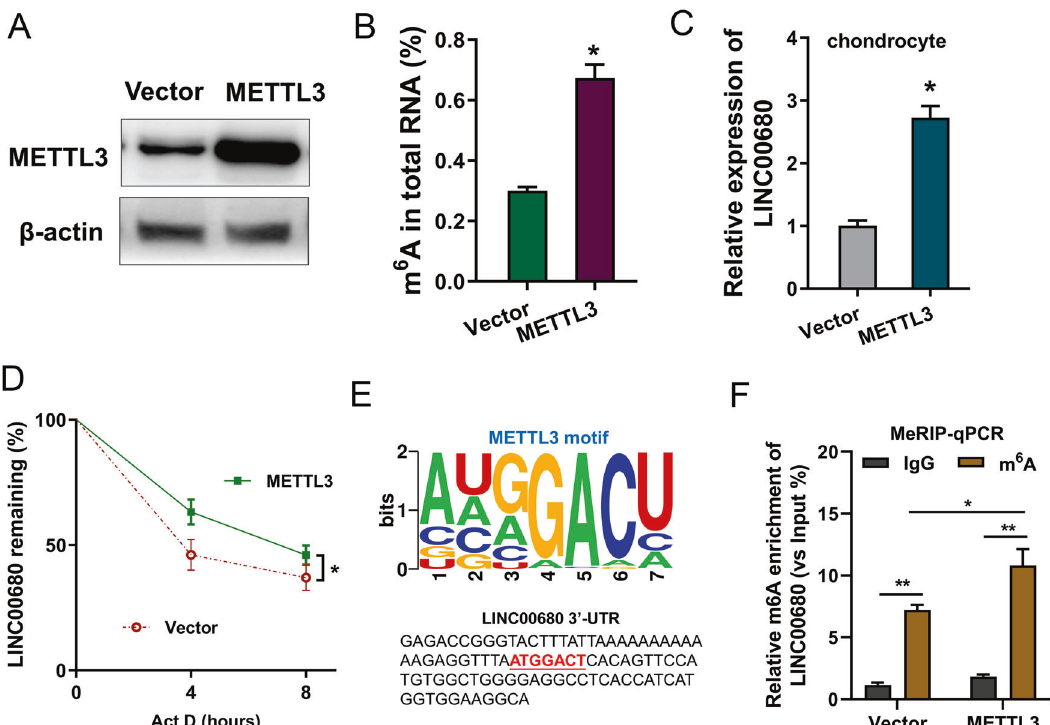
Fig. 2 METTL3 enhanced the stability of LINC00680 in IL-1 β -induced chondrocyte. A Western blot analysis detected the METTL3 protein level in IL-1 β -induced chondrocyte transfected with METTL3 overexpression plasmids. B m 6 A modi fi cation quantitative analysis indicated the m 6 A modi fi cation enrichment upon the METTL3 overexpression as compared to control. C RT-qPCR analysis was performed to quantify the LINC00680 expression in chondrocyte upon the METTL3 overexpression as compared to control. D Act D treatment (2 mg/mL) for RNA stability was performed to detect LINC0068 expression using RT-qPCR. E Online predictive tools (RMBase, http://rna.sysu.edu.cn/rmbase/) demonstrated the m 6 A modi fi ed site in 3 ′ -UTR of LINC00680. The m 6 A motif matched with METTL3 is GGACU. F MeRIP-qPCR illustrated the enrichment of m 6 A modi fi cation on LINC00680 in chondrocyte upon the METTL3 overexpression as compared to control. Experiments ’ data were repeated in triplicate. *Indicates the p < 0.05, and **Indicates the p <